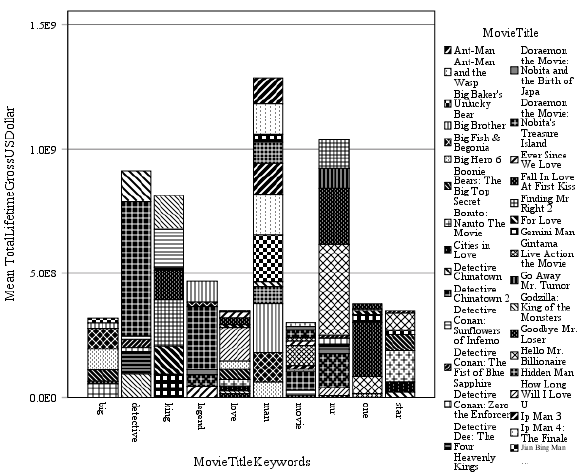
Figure 4. Top 10 most popular movie title keywords and their corresponding movie titles in China.